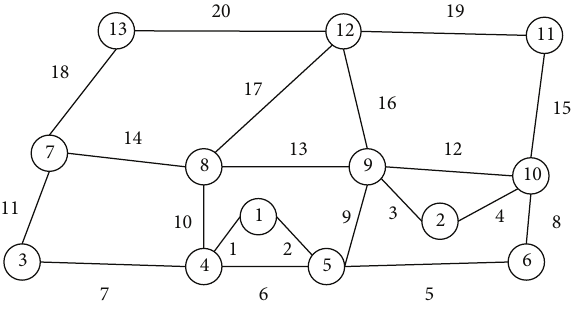
Figure 2: Typical evacuation